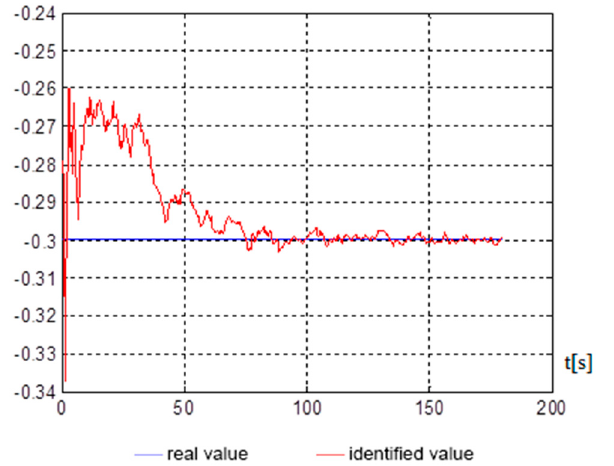
Figure 6. K v assessment over time. Figure 6. v K assessment over time. Figure 6. v K assessment over time.